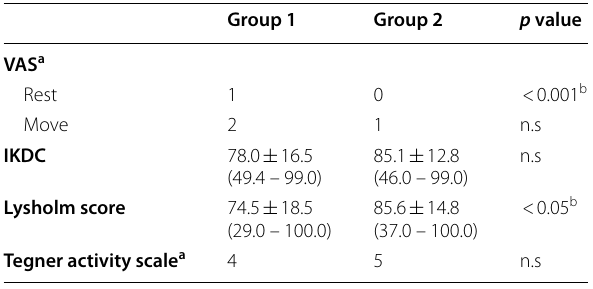
Continuous variables are shown as mean VAS Visual Analogue Scale (pain), IKDC International Knee Documentation Committee, n.s. not